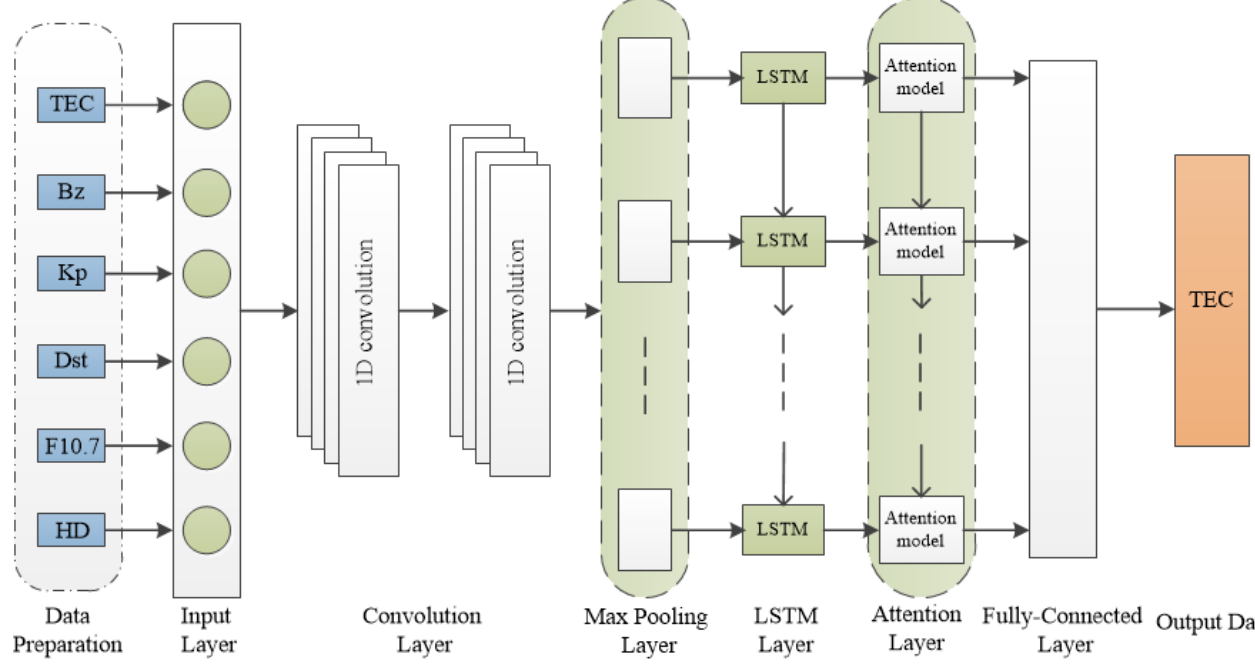
Figure 3. The structural framework of CNN-LSTM-Attention neural network model. The model consists of input layer, convolution layer, pooling layer, LSTM layer, attention layer, and fully-connected layer. Input data, output data, and all layers of data flow in the model are marked.